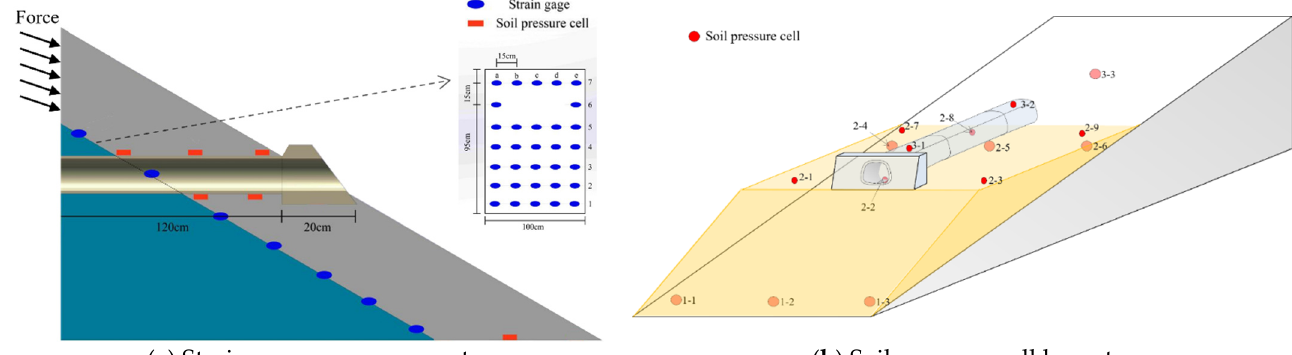
Figure 3. Diagram of soil pressure cell layout and strain gauge arrangement.